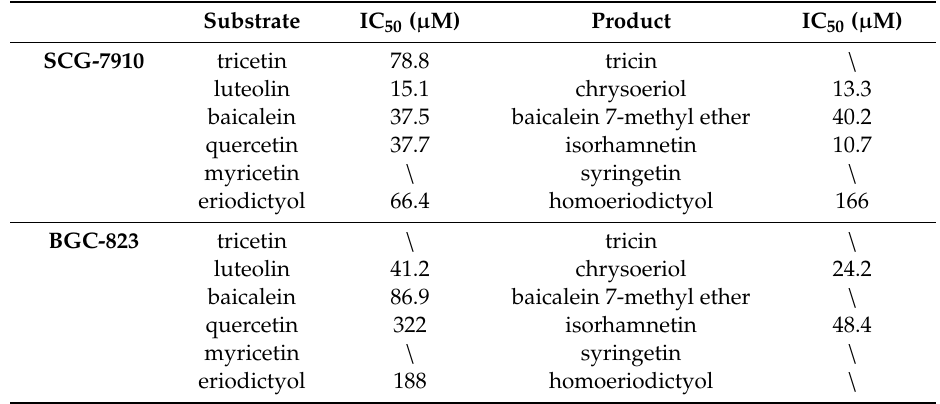
Table 1. Inhibitory e ff ects of flavonoids catalyzed by Citrus reticulata O -methyltransferase 2 (CrOMT2) on the human gastric cancer cells in vitro.